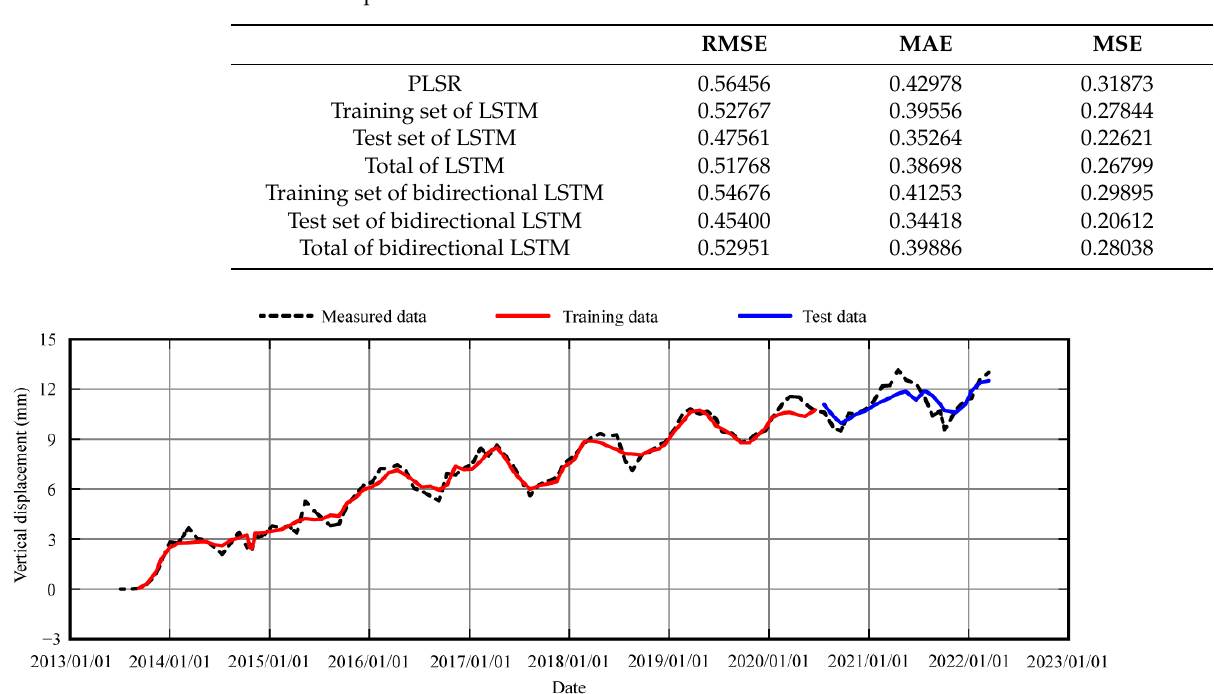
Figure 6. Process lines of settlement for measuring point LD16YT01 (bidirectional LSTM model).